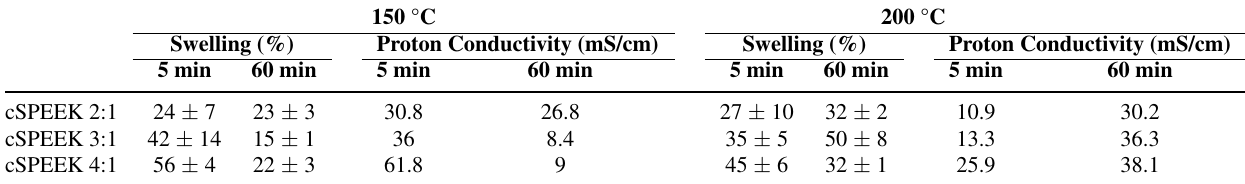
Table 1. Swelling and proton conductivity of different cSPEEK membranes with different SPEEK:crosslinker ratios (2:1, 3:1 and 4:1), for which the error of the conductivity data was reproducible in the range of 0.01%. In our experiments, Nafion reached at room temperature a proton conductivity up to 80.1 mS/cm, where a swelling of up to 26 wt% was